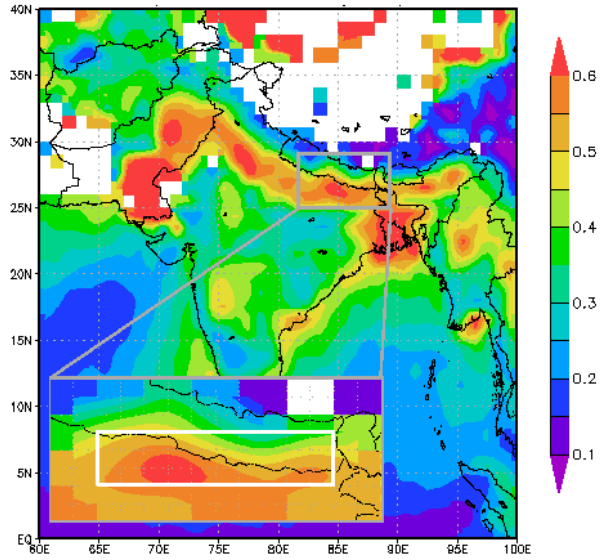
Fig. 8. Satellite (MODIS) integrated AOD over South Asia during pre-monsoon 2006. The white box in the zoomed region represents the area (26 ◦ N ≤ Lat ≤ 27.5 ◦ N; 83 ◦ E ≤ Lon ≤ 88 ◦ E) used to cal- culate daily AOD values over the Himalayan foothills and North IGP (courtesy of Giovanni on-line data system from the NASA GES